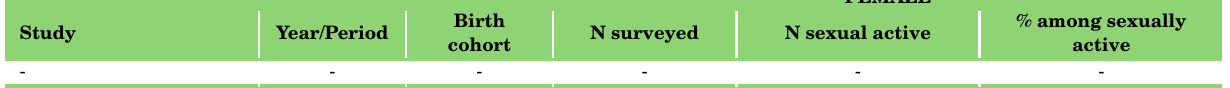
Table 44: Lifetime prevalence of anal intercourse among women in